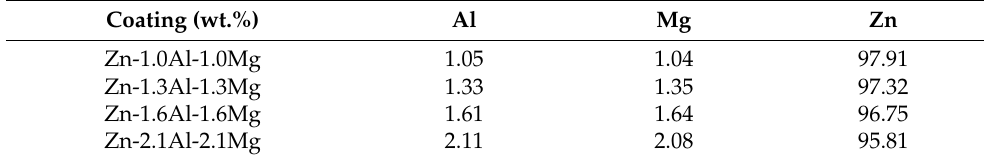
Table 1. The compositions of experimental coatings. Coating